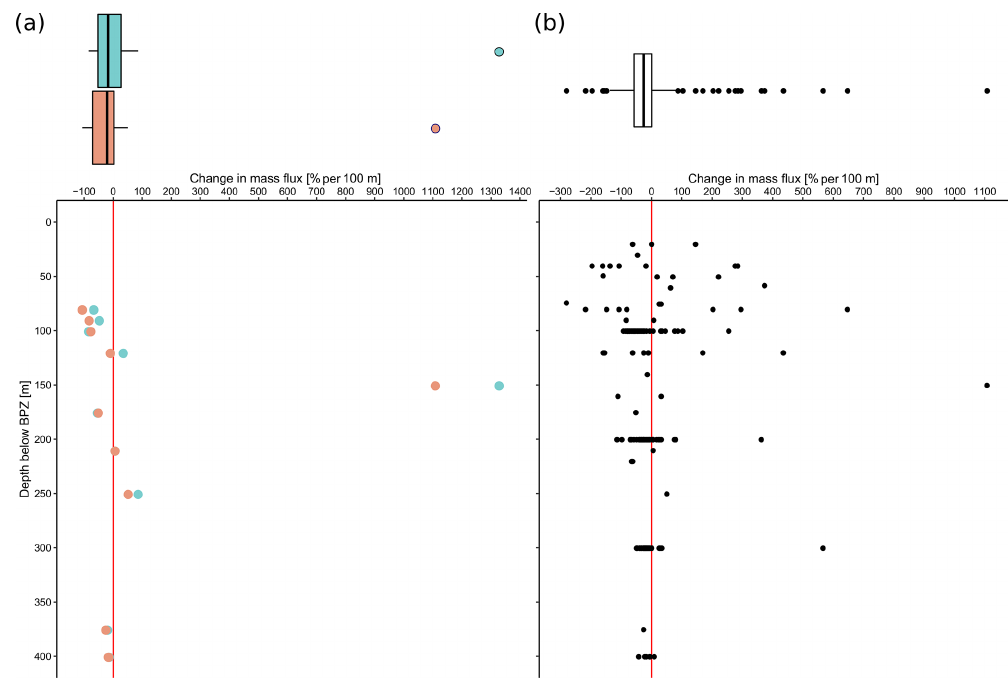
Figure 9. Flux loss with depth per 100m (in %), calculated between different sampling intervals located below the interval including the base of productive zone, plotted against the distance between the maximum sampling depth of the individual interval and the end of the net including the base of the productive zone. Panel (a) is a comparison of loss in shell number concentration (blue) and shell mass (orange) in PS93.1 samples from the Fram Strait, and (b) shows the loss in mass flux of all samples, estimated based on average shell weight and shell number concentration. The boxes and bars on top of the plots represent the interquartile range as explained in the caption of Fig. 3 and are plotted against the same x axis as the plot